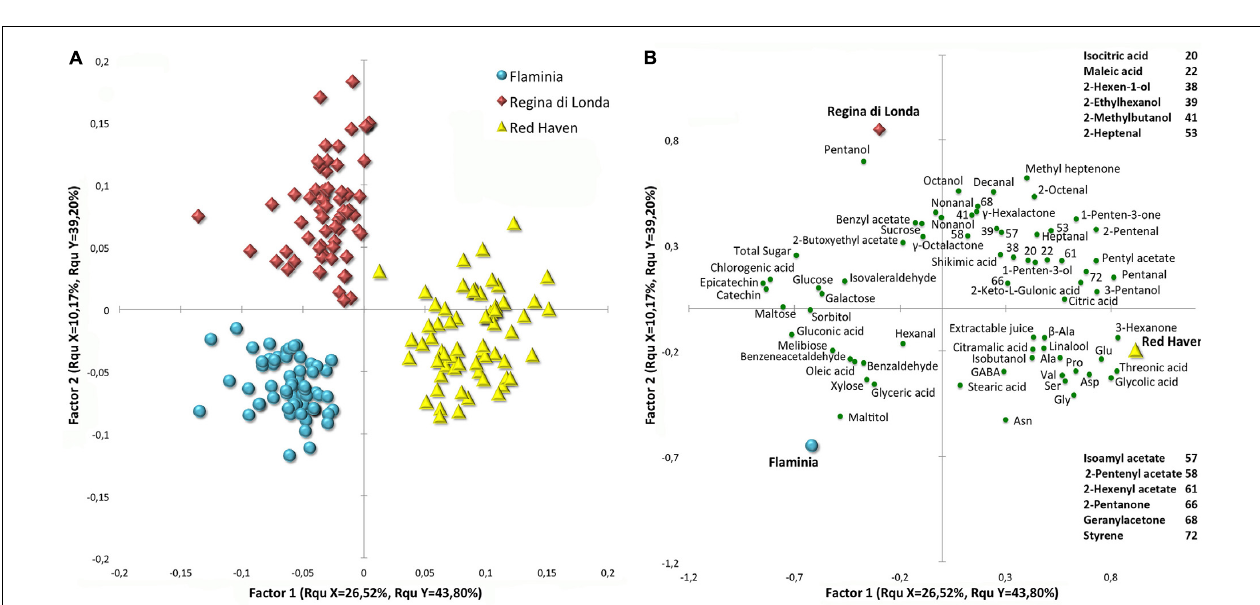
FIGURE 3 | Principal component analysis (PCA) of cold storage and shelf-life (SL) data together pointing out the effects of storage conditions ( A , PC1 vs. PC2) and storage time ( B , PC1 vs. PC4). Circles, diamonds and triangles are used depicting ‘Flaminia’ (FL), ‘Regina di Londa’ (RL), and ‘Red Haven’ (RH) peaches, respectively, in both (A,B) . (A) Light blue, blue, red, orange, and yellow colors indicate 0.5 ◦ C, 5.5 ◦ C, control, 0.5 ◦ C + SL and 5.5 ◦ C + SL peaches, respectively, including in each cluster samples from 0 to 4 weeks of storage (3 weeks for control fruit). (B) Colors from dark blue to red indicate samples from 0 to 4 weeks of storage (3 weeks for control fruit) and each group includes samples from all the tested conditions.